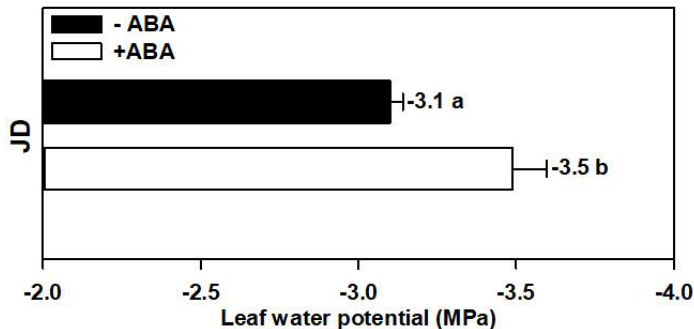
Figure 6. The effect of 10 µM exogenous ABA on lethal leaf water potential of the soybean cultivar Jindou 19 (JD). One day before withholding water, plants were pretreated with (+ABA) or without (−ABA) 10 µM exogenous ABA. Values are means ± SE ( n = 6).